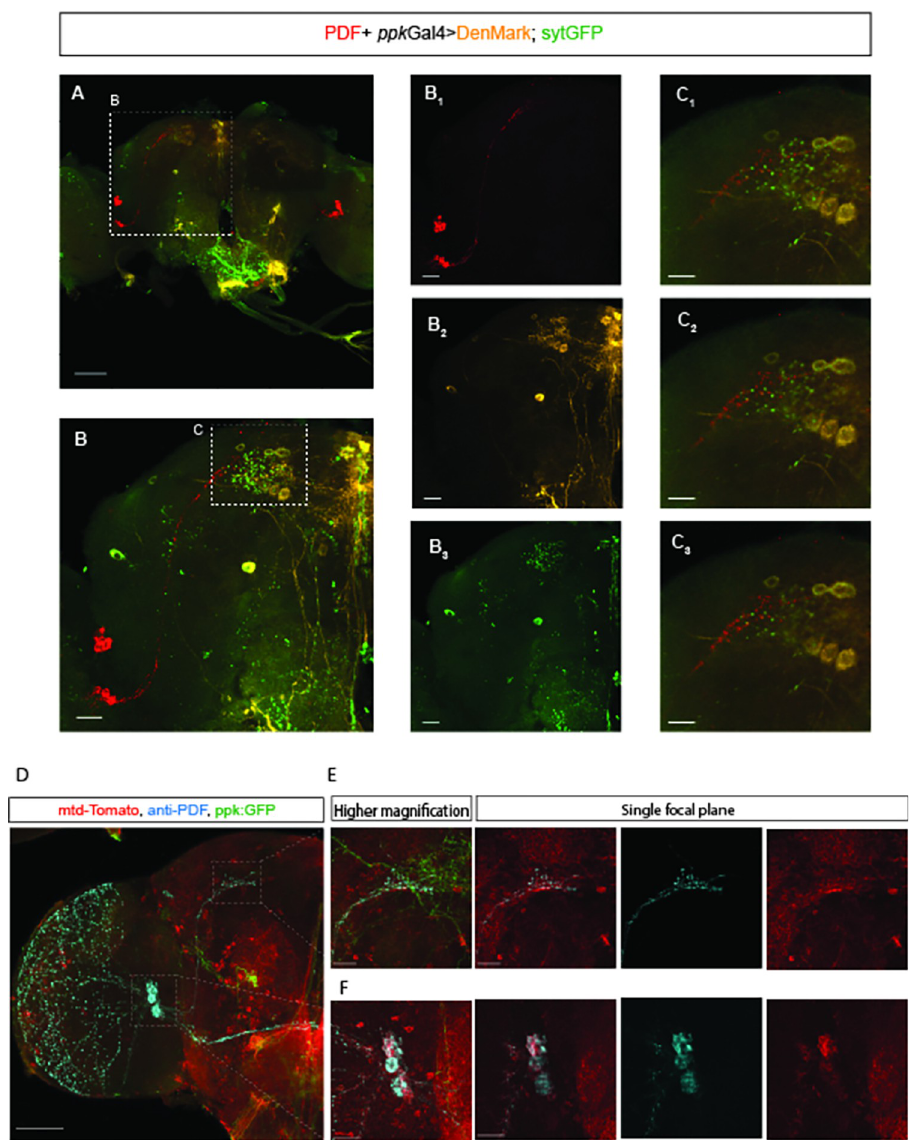
Fig 4. pdf + LNv neurons are postsynaptic targets of ppk + neurons. (A) The dendritic arbors and presynaptic terminals of ppk + neurons were visualized by expression of the postsynaptic marker DenMark (orange) and the presynaptic marker syt-GFP (green), in a mated female brain. pdf+ neurons were visualized with anti-PDF (red). The bar indicates 10 μ M. (B) A higher magnification of the dashed region shown in (A). (B1 , B2 , B3) Brains of flies co- expressing UAS-DenMark and UAS-syt-GFP reporters in ppk + neurons, stained with anti-PDF ( B1 ) , with anti-DsRed (DenMark, orange, postsynaptic) ( B2 ) and with anti-GFP (green, presynaptic) (B3) . (C1 , C2 , C3) Single plane confocal images of the region (C) highlighted in panel (B) displaying the area in the protocerebrum where the presynaptic termini of ppk + neurons are in close apposition to pdf + neurons. Scale bars, 10 μ m. (D) Trans-synaptic labeling using trans -Tango. Representative confocal image of a ppk -Gal4 > UAS-myr-GFP, QUAS-mtdTom; trans-Tango mated female brain. Brains were co-stained with anti-PDF (cyan) to identify pdf + neurons, anti GFP (green) to highlight ppk + presynaptic neurons and anti-DsRed (red) to identify putative ppk postsynaptic partners. The bar indicates 60 μ m. (E , F) Higher magnification of the dorsal ( E ) and accessory medulla ( F ) regions of a mated female brain. The rightmost image of B and C panel shows single focal planes of an overlap between presynaptic and postsynaptic ppk+ contacts at PDF-expressing neurons in the accessory medulla (C) and in the dorsal termini of pdf+ axons (B). Bars indicate 20 μ